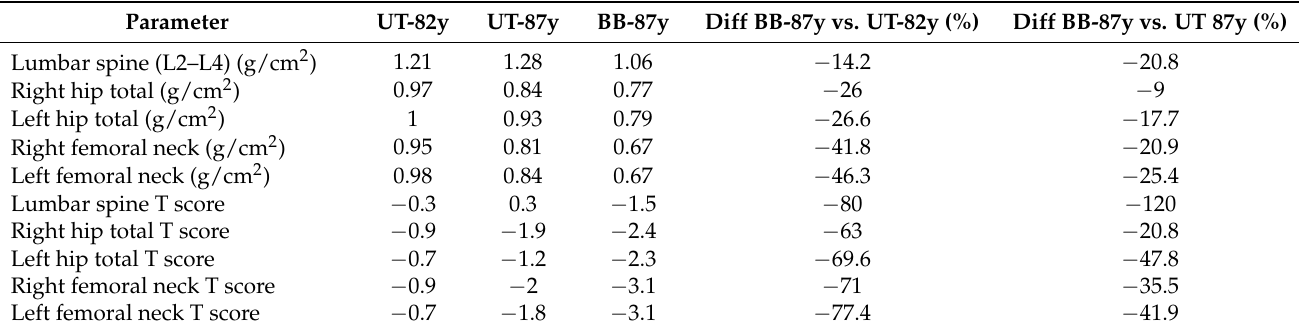
0.98 Chest press and leg press 1RM and PP was expressed with allometric scaling and performances were greater for BB-87y compared to UT older males (ranging from 13.6% to 55.8%) with a trend towards increased differences in performances when compared to UT-87y (Table 2). Chest press PP for BB-87y was slightly lower compared to UT-82y ( − 5%) but greater compared to UT-87y (+20.6%). Leg press PP was also greater for BB-87y compared to UT-87y (+30.8%), but no comparison could be made to UT-82y since he did not Medical Systems, Madison, WI, USA). perform this measure. Chest press and leg press 1RM performances were also expressed relative to upper and lower body lean mass, respectively, to provide an indication of